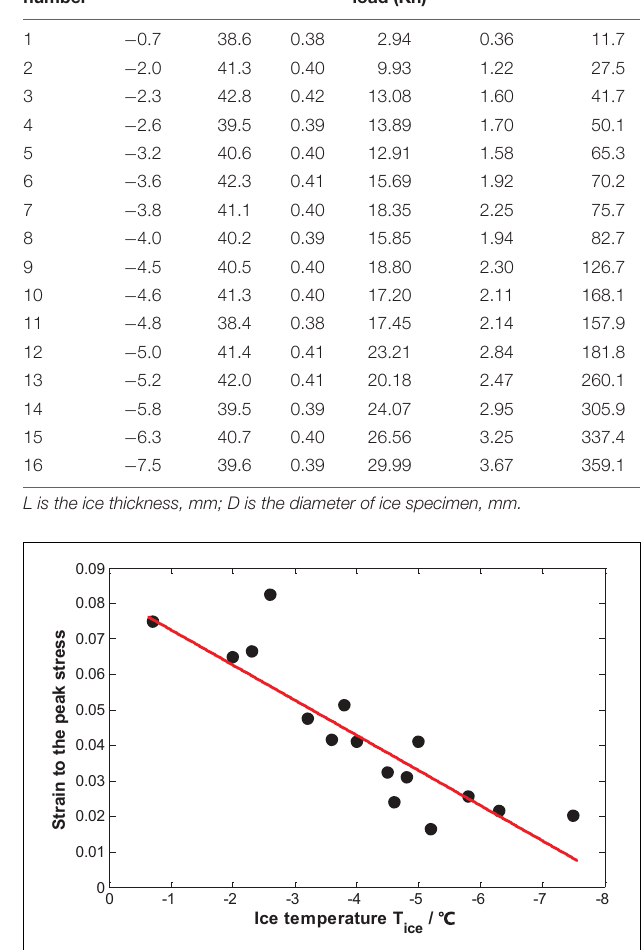
FIGURE 9 | Uniaxial unconfined compressive strength of ice for various